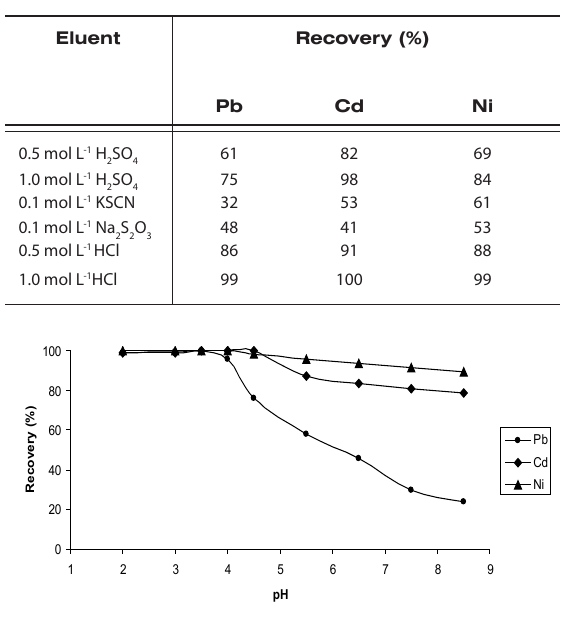
Figure 1. The influence of the pH of aqueous solution on the recovery of analyte ions. Conditions: lead and nickel, 10.0 µg; cadmium, 5.0 µg; Buffer, 2 mL; flow rate of sample, 1 mL min -1 ; final